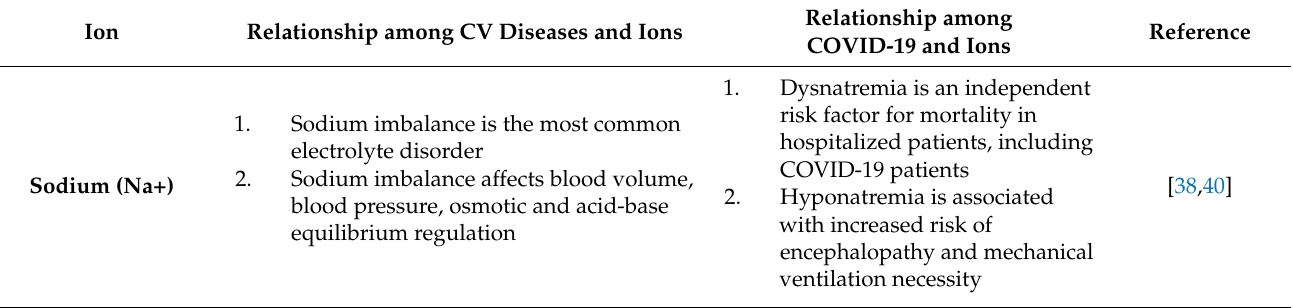
Table 1. A summary of the most important ions imbalance during COVID-19 and their effects on CV